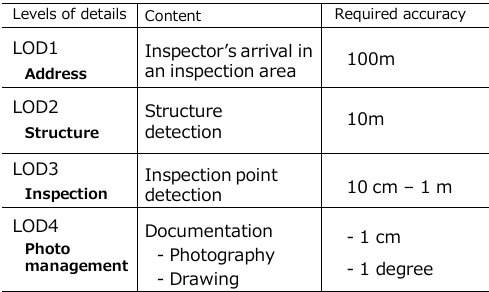
Table 2. LODs in infrastructure